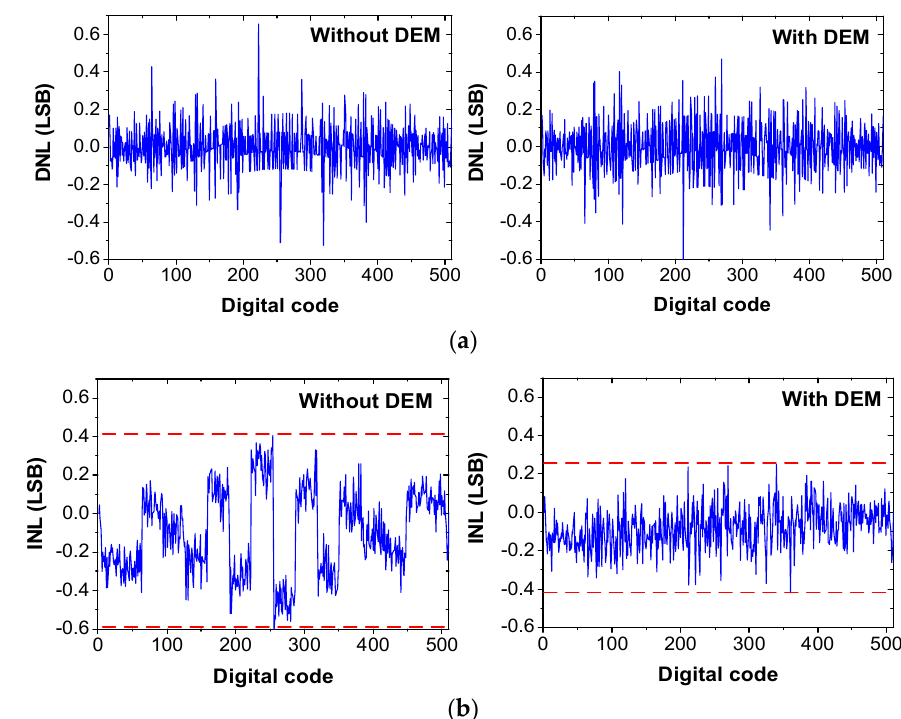
Figure 19. Comparison of the static performance of the ADC with and without the DEM. ( a ) DNL, ( b ) INL.